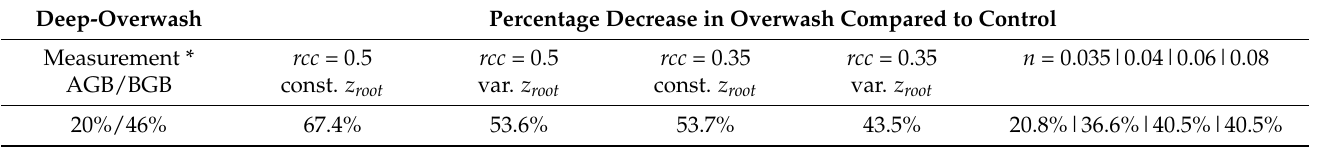
Table 6. Percentage decrease in overwash compared to the control cases for deep overwash.